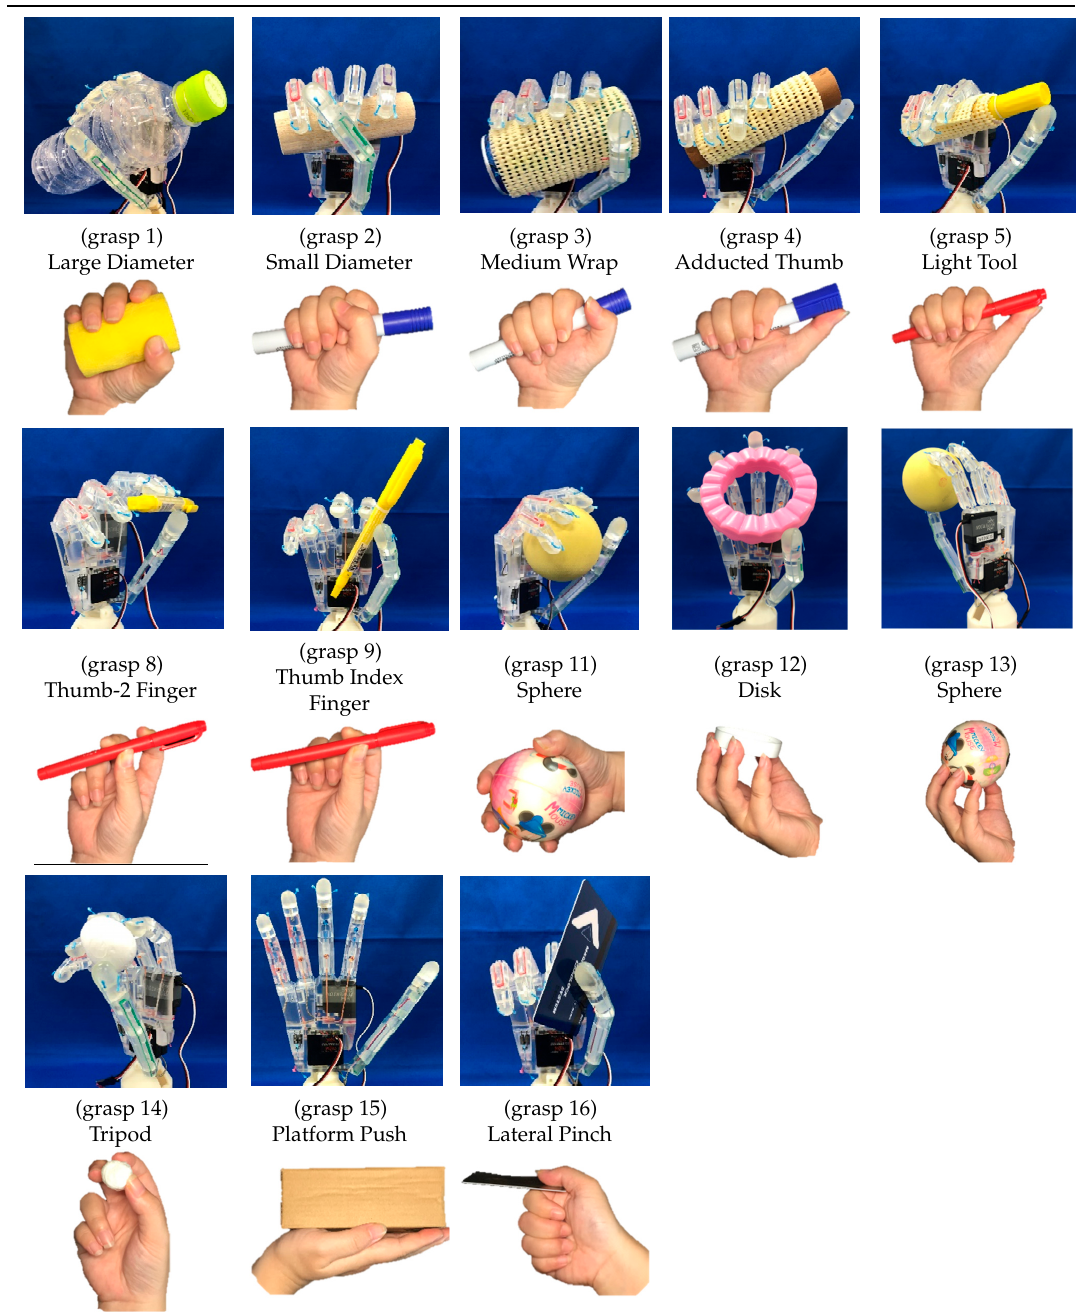
Table 3. Achievable motion types.